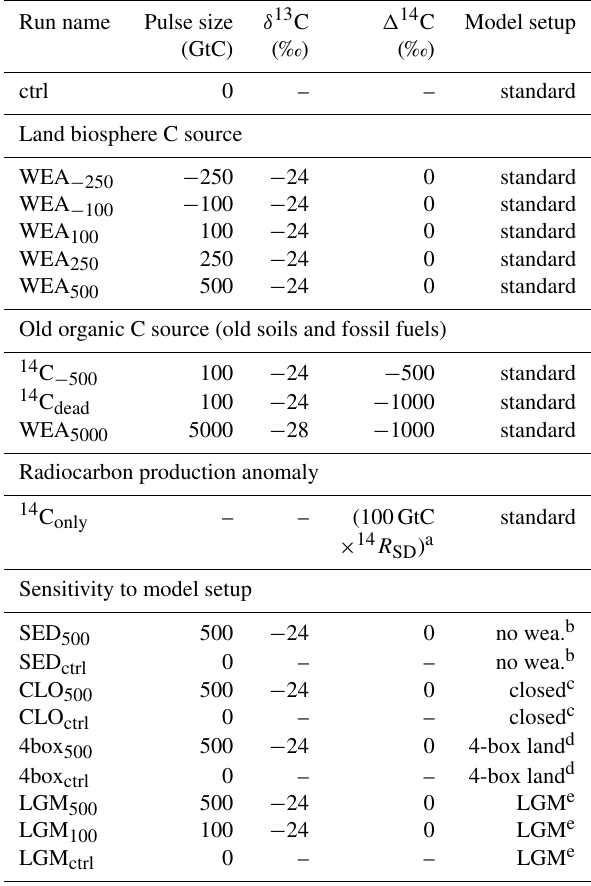
Table 1. Overview of